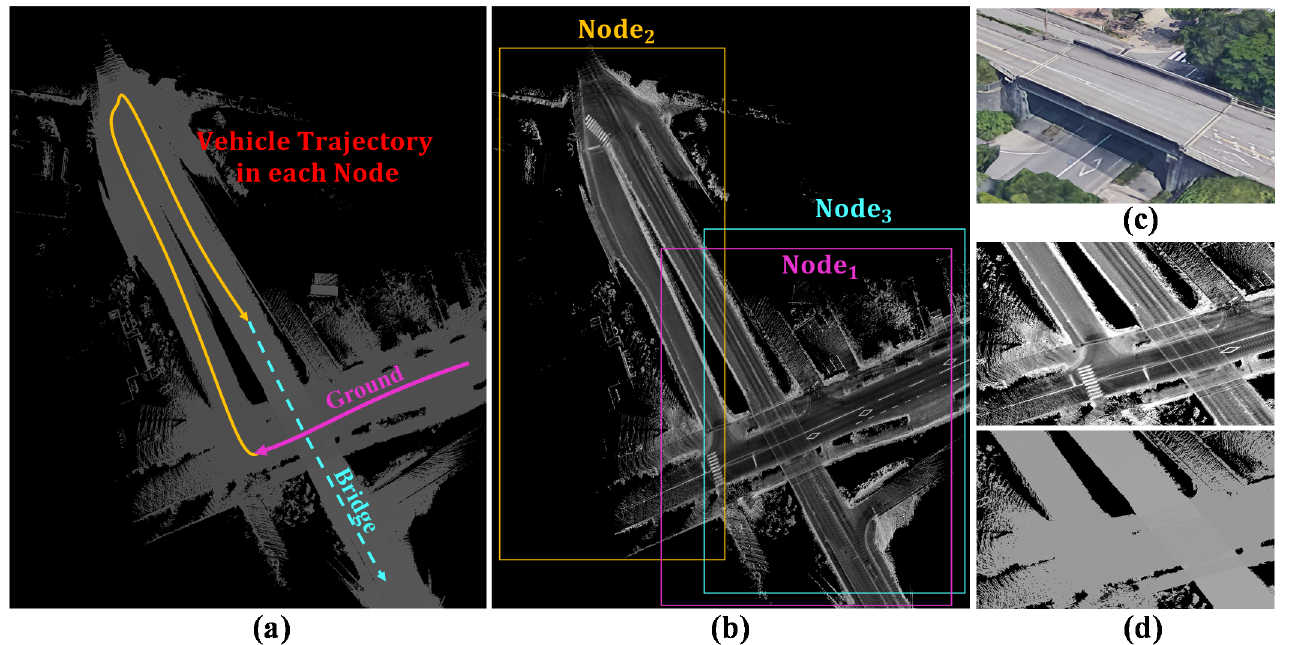
Figure 3. ( a ) Ground and bridge road structure represented by an elevation map showing the vehicle trajectory. ( b ) Intensity map consisting of three nodes. ( c ) Common area between bridge and ground road surfaces. ( d ) Intensity (top) and elevation (bottom) images of overlapped area.